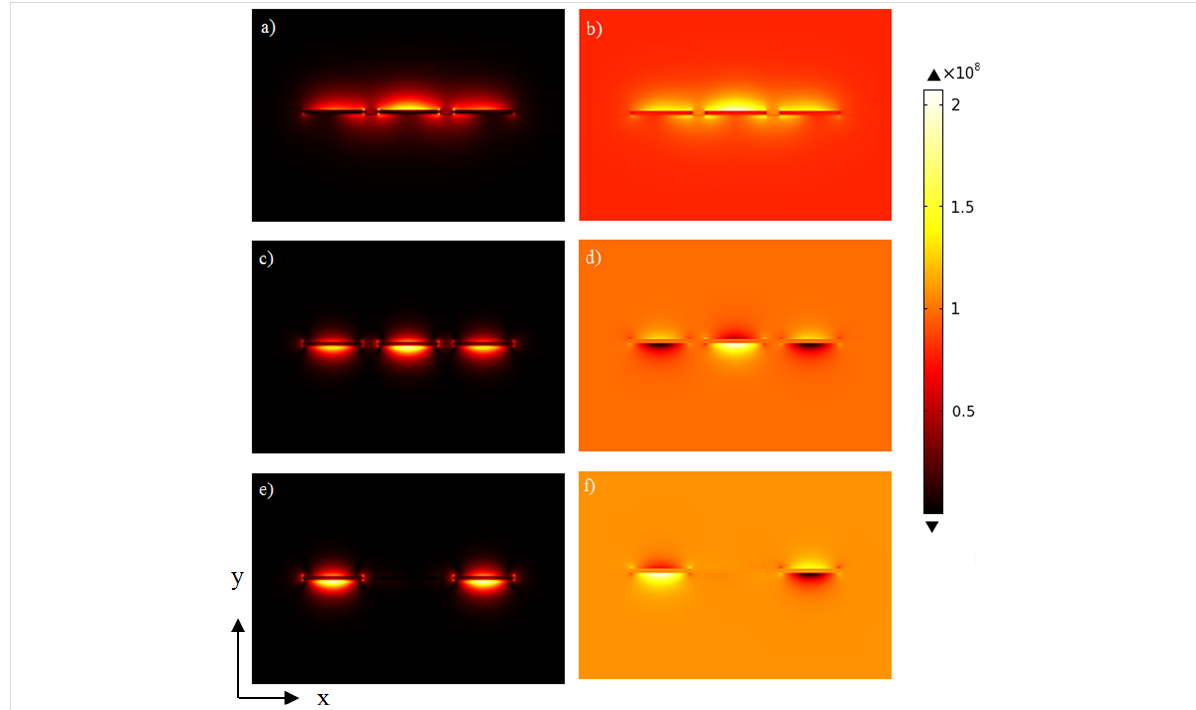
Figure 2: (a), (c) and (e): Magnitude of the electric field distribution of the eigenmodes 1, 2 and 3. (b), (d) and (f): The y -component of the electric field for eigenmodes 1, 2 and 3. Stripes are made from silver, 750 nm wide, 30 nm thick, and separated by 200 nm on ITO coated glass substrate with PMMA cladding for an excitation wavelength of 633 nm. These simulations were done using COMSOL